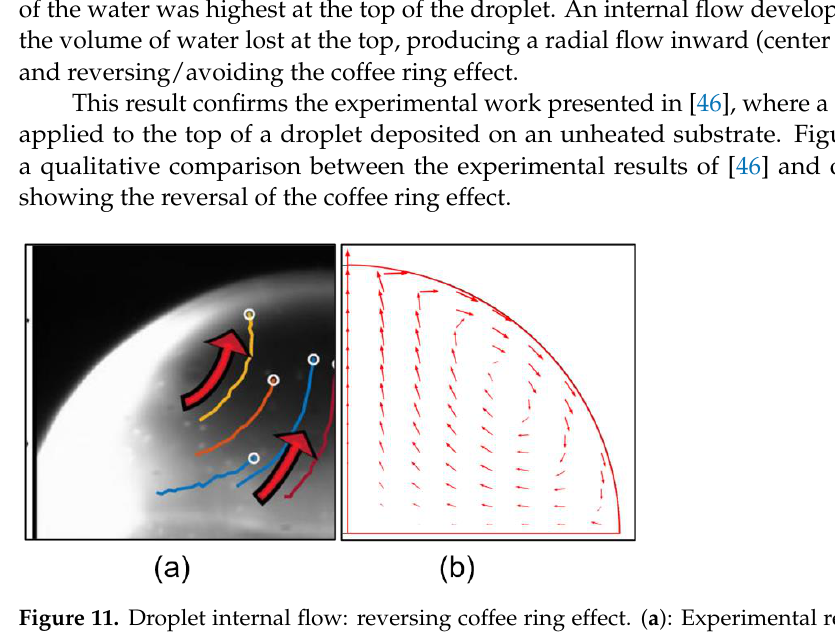
Figure 10. Streamlines and flow direction inside water droplet for two configurations. (t = 1 s, V 0 = 1 mm 3 ,  = 90°) ( a ): BH (T = 50 °C) ( b ): TH (Φ = 40 mW).